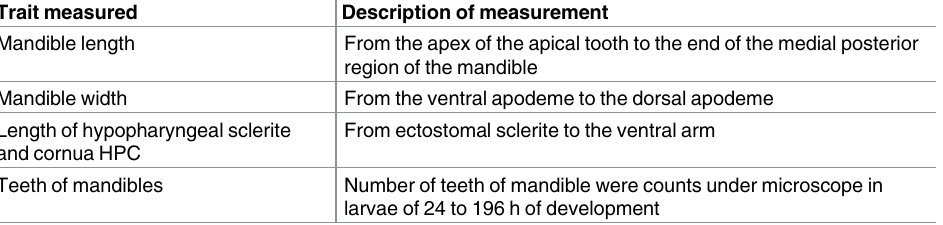
Table 3. Mandible M and Hypopharyngeal sclerite and Cornua HPC measurements performed in lar- vae of D . gaucha . The larvaewere of the CJ and BA strains and F 1 , F 2 and reciprocal backcrosses. Larvae